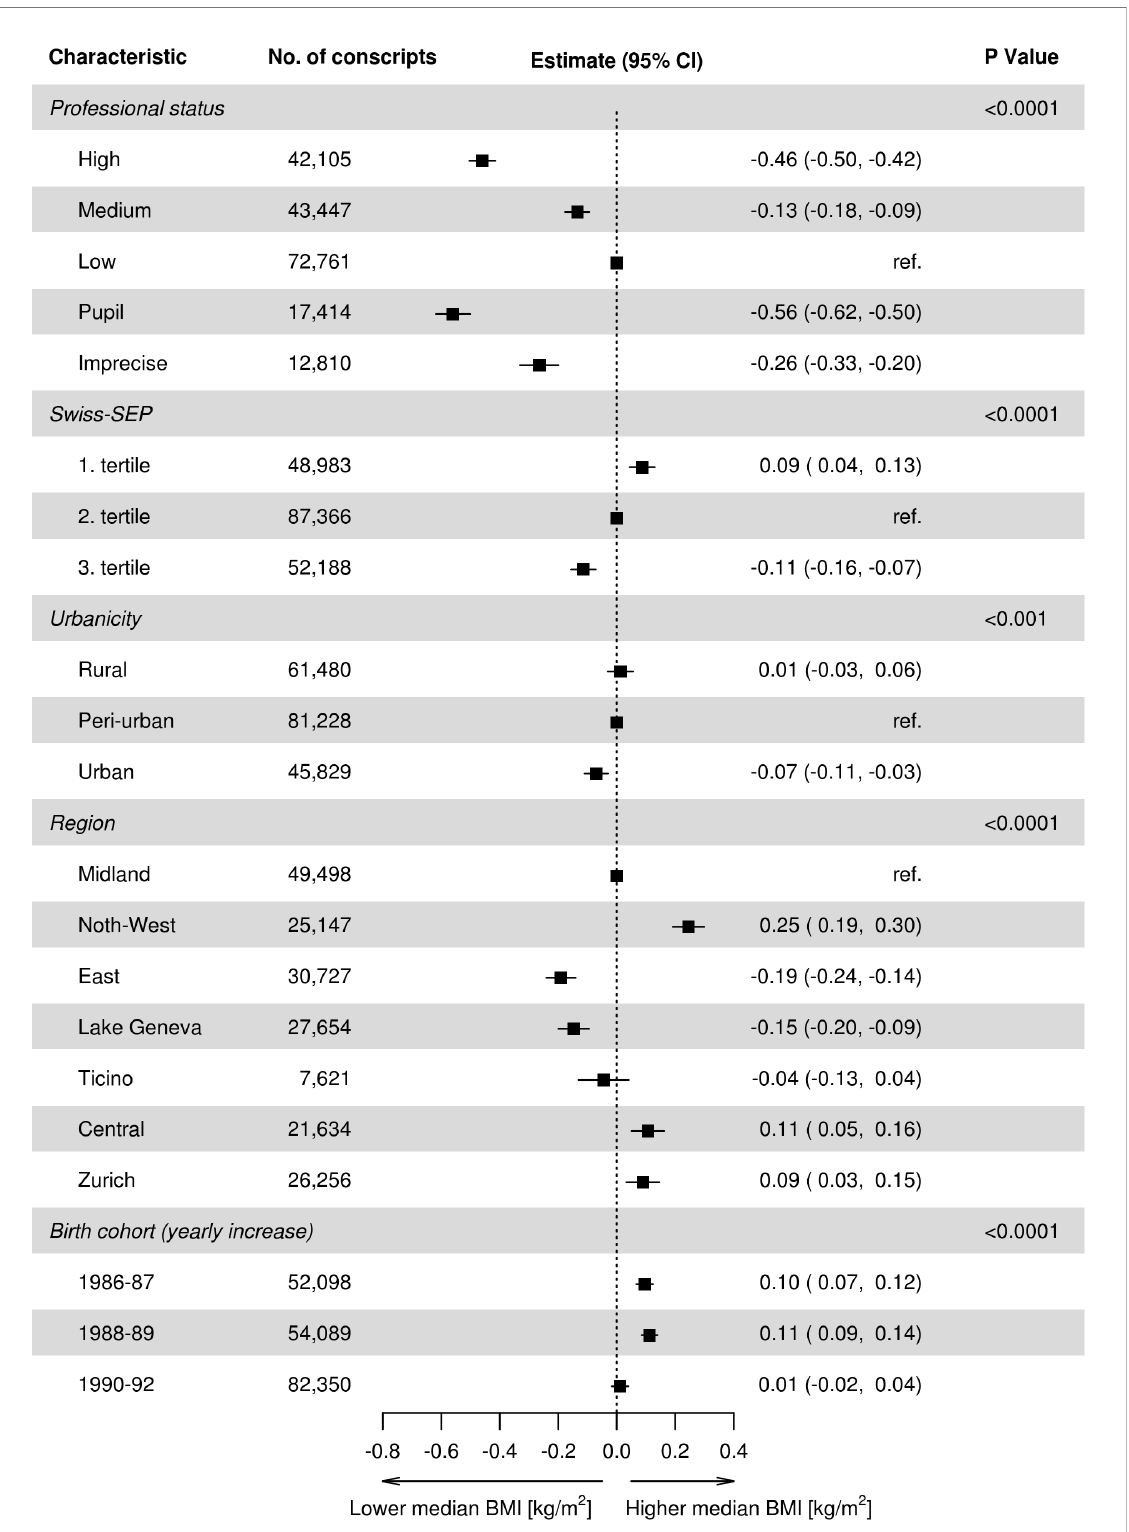
Figure 2. Differences in median BMI (95% confidence intervals (CI)) estimated from the first multivariable quantile regression model of Swiss conscripts across professional status, tertiles of median Swiss-SEP index of postcode of residence, degree of urbanicity and region of residence. Model adjusted for linear splines for birth-year period.